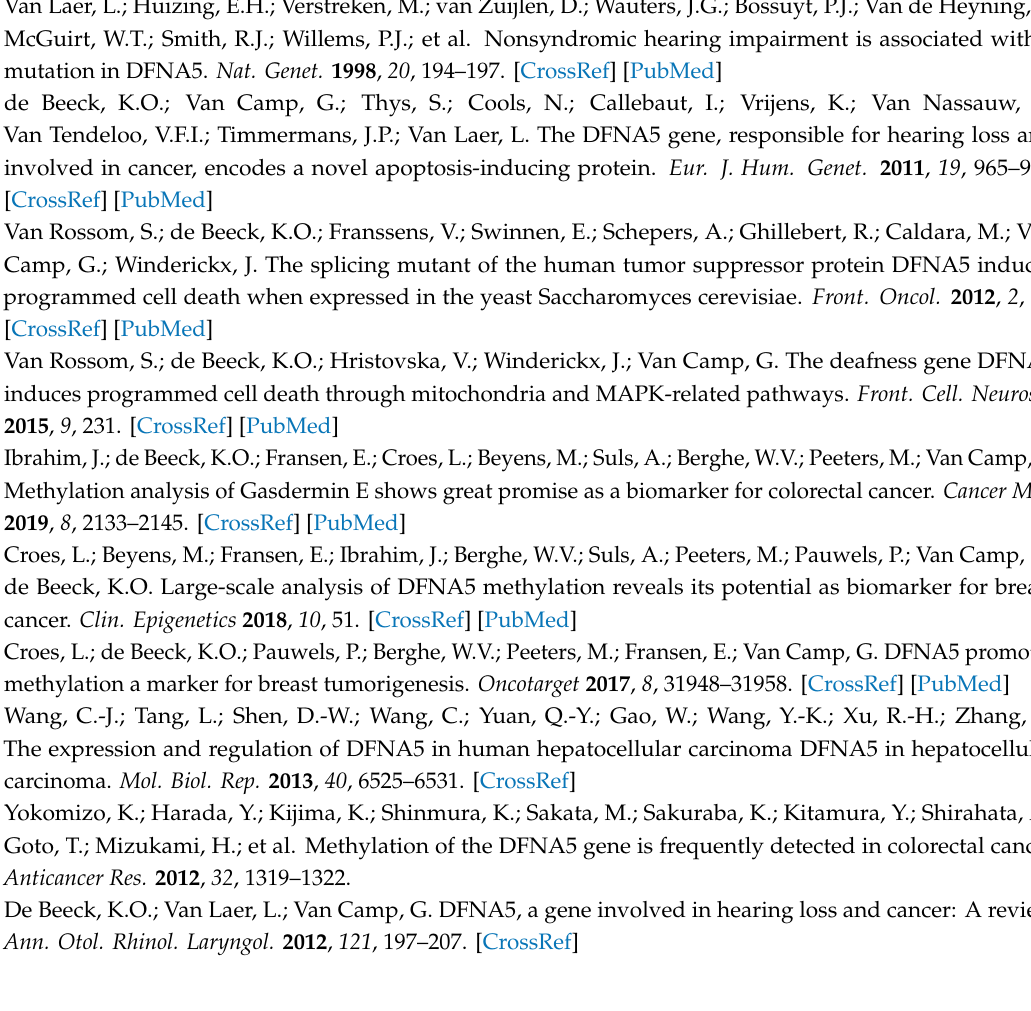
Table S7: Mastermix for the Gsdme genotyping PCR, Table S8: Cycling parameters Gsdme genotyping PCR, Table S9: Primers for Apc 1638N genotyping, Table S10: Mastermix for the Apc 1638N genotyping PCR, Table S11: Cycling parameters Apc 1638N genotyping PCR, Figure S1: Pathologies in the liver of AOM-treated mice. Author Contributions: Conceptualization, G.V.C., K.O.d.B., and L.C.; methodology, G.V.C., K.O.d.B., L.C., P.P., and M.P.; formal analysis, L.C. and E.F.; investigation, L.C., M.H., K.B., and C.H.; resources, G.V.C., K.O.d.B.,